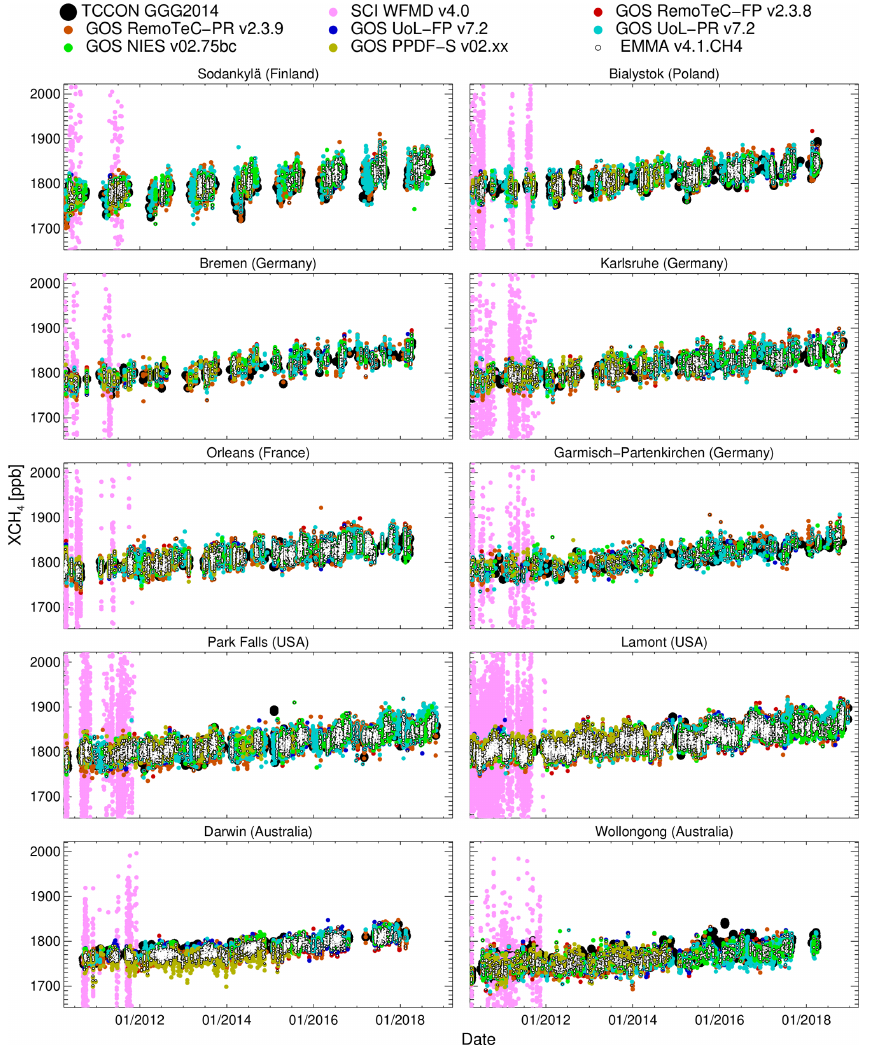
Figure A2. XCH 4 time series at 10 TCCON sites during April 2010–December 2018 as obtained using the EMMA quality assessment method. TCCON GGG2014 XCH 4 is shown as thick black dots, the individual satellite L2 input products are shown as colored dots, and the EMMA product is shown as a white circles with black borders. The derived numerical values are listed in Table